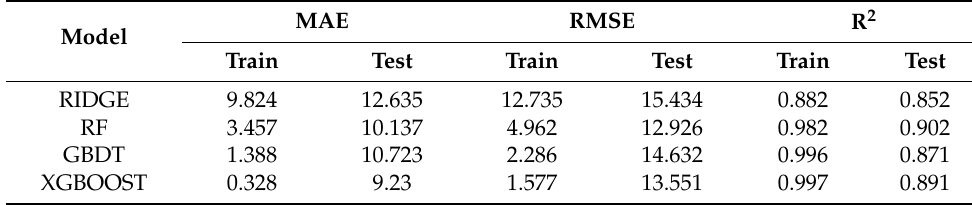
Table 2. Comparison of train and test sample results in ten